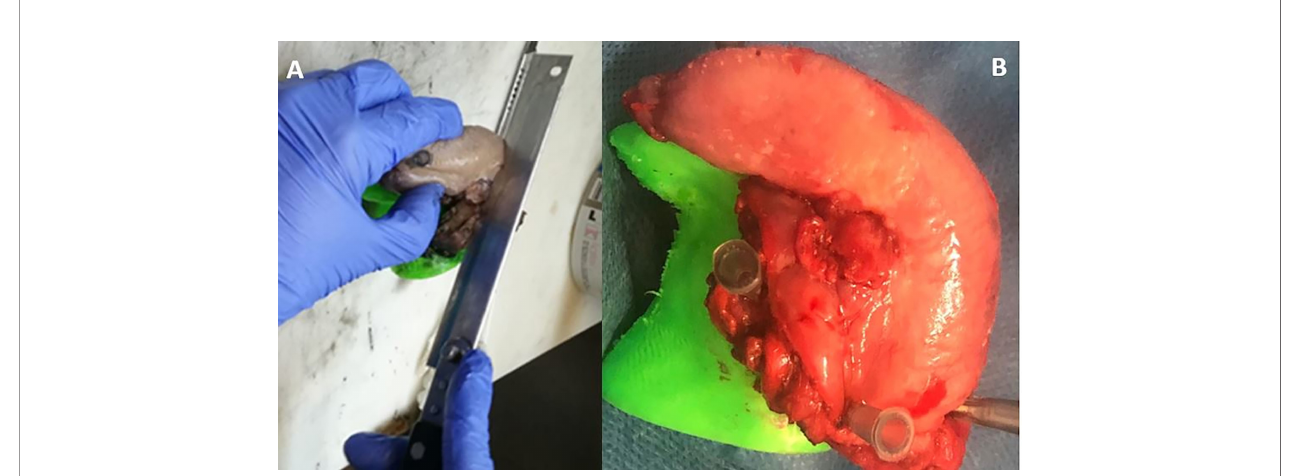
FIGURE 4 | Dissection of the specimen into 3 – 5 mm slices (A, B) parallel to MRI planes to evaluate the distance from the tumour to the surface of the